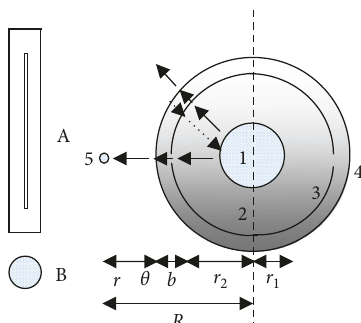
Figure 2: Schematic of the slot blasting